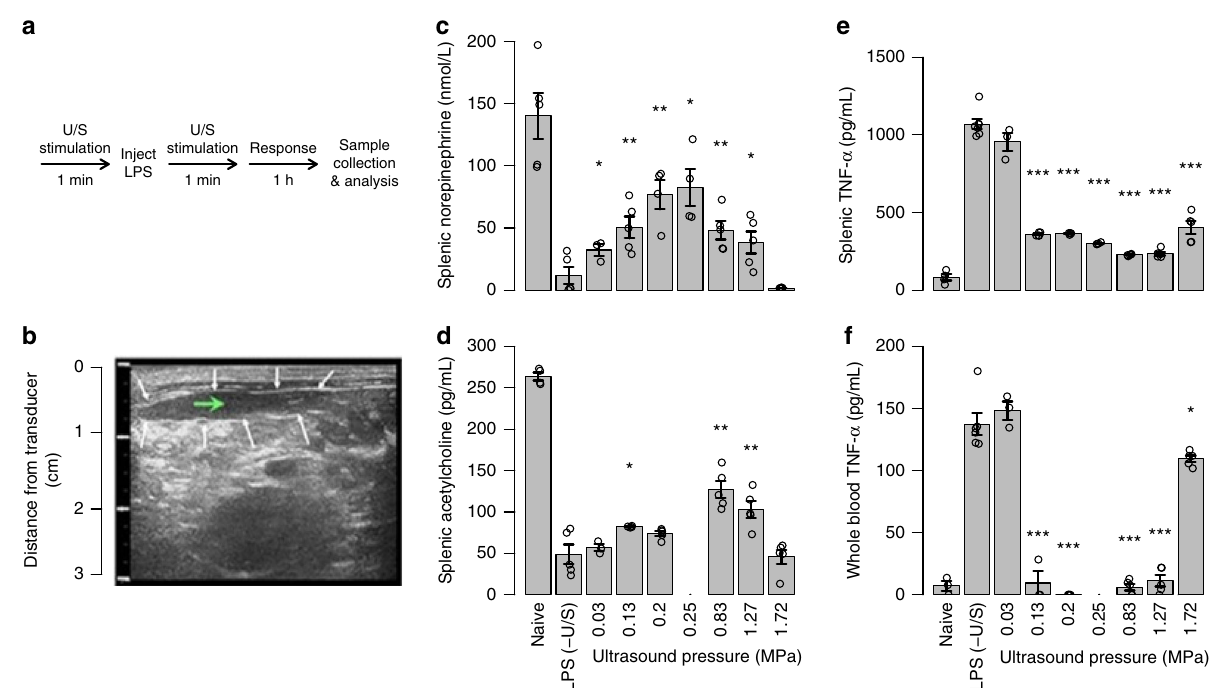
Fig. 2 Splenic U/S neuromodulation of the cholinergic anti-in fl ammatory pathway (CAP). a The timeline of the U/S neuromodulation performed in the LPS- induced in fl ammation model (see Methods and Supplementary Figures 1 – 6 for details; stimulation parameters were 1.1 MHz, 136.36 µ s pulse length, and 0.5 ms pulse repetition period). b Example U/S image of the spleen used to locate the U/S stimulus (white arrows — outline of the spleen; green arrow — target point for U/S stimulation). c – e Splenic concentrations of CAP signaling molecules, including norepinephrine ( c ), acetylcholine ( d ), and TNF ( e ) are shown for naive animals, sham controls (LPS, -U/S), and with U/S stimulation (0.03 – 1.72 MPa). f Whole-blood concentrations of TNF for the same conditions as ( e ). The asterisks mark statistical signi fi cance using two-sided t -test versus LPS only controls (with p -value thresholds; * p < 0.05, ** p < 0.01, *** p < 0.001). n = 5 for all experiments in this fi gure except for all LPS − (U/S) controls which were n = (anti-in fl ammatory) versus the hepatic (metabolic) pathways. The splenic stimulation data demonstrates a clear ultrasound “ dose response ” to norepinephrine with a distinct power level required for cytokine reduction in the endotoxin model, and an effective power range commensurate with potential clinical use.